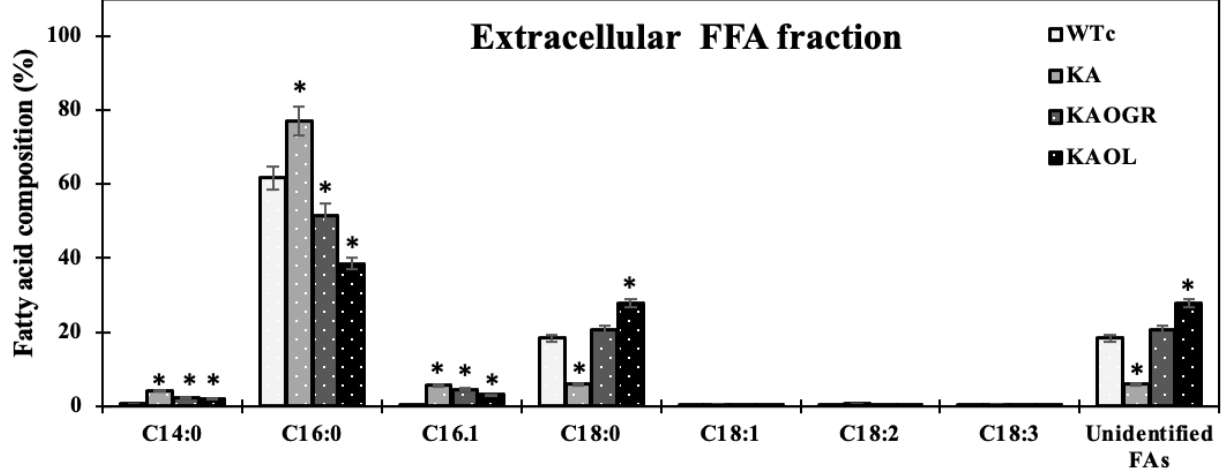
Figure 6. Fatty acid compositions (%) in extracellular fraction analysed by a GC instrument in Synechocystis PCC 6803 WTc and all engineered strains. Cells were grown in BG 11 medium for 10 days before being analysed. Error bars represent standard deviations of means (mean ± S.D., n = 3). The statistical differences of the results between the WTc and engineered strains are indicated by an asterisk *, p < 0.05.